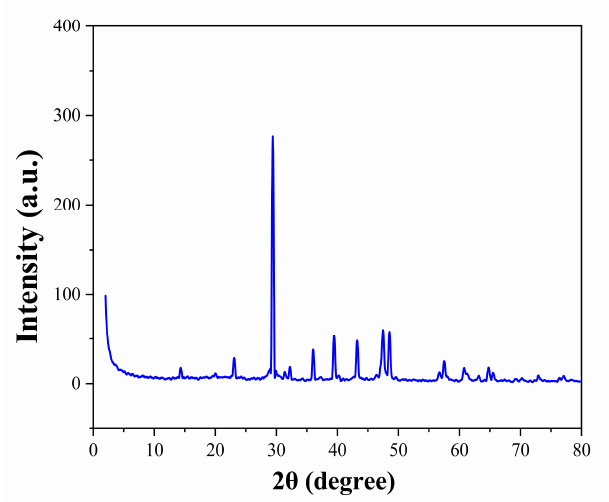
Figure 3. FTIR spectra of calcium peroxide.